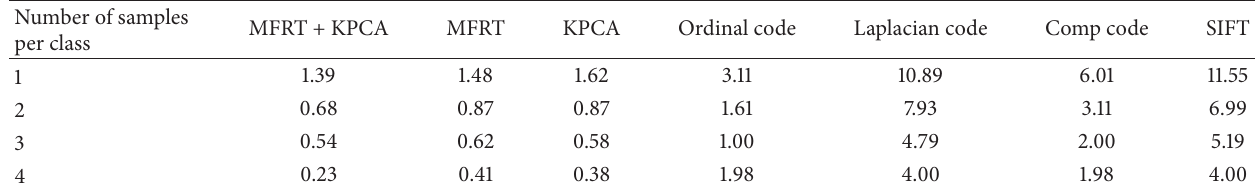
Table 7: Equal error rate accuracy measures from CASIA palm print database.